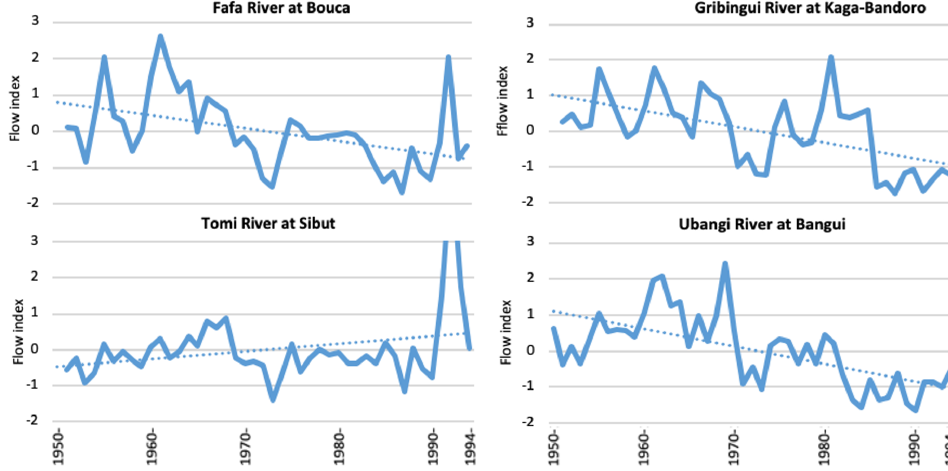
Figure 3. Interannual evolution of flow index over 1951–1995. Table 2. Years of ruptures detected in hydrological time series per